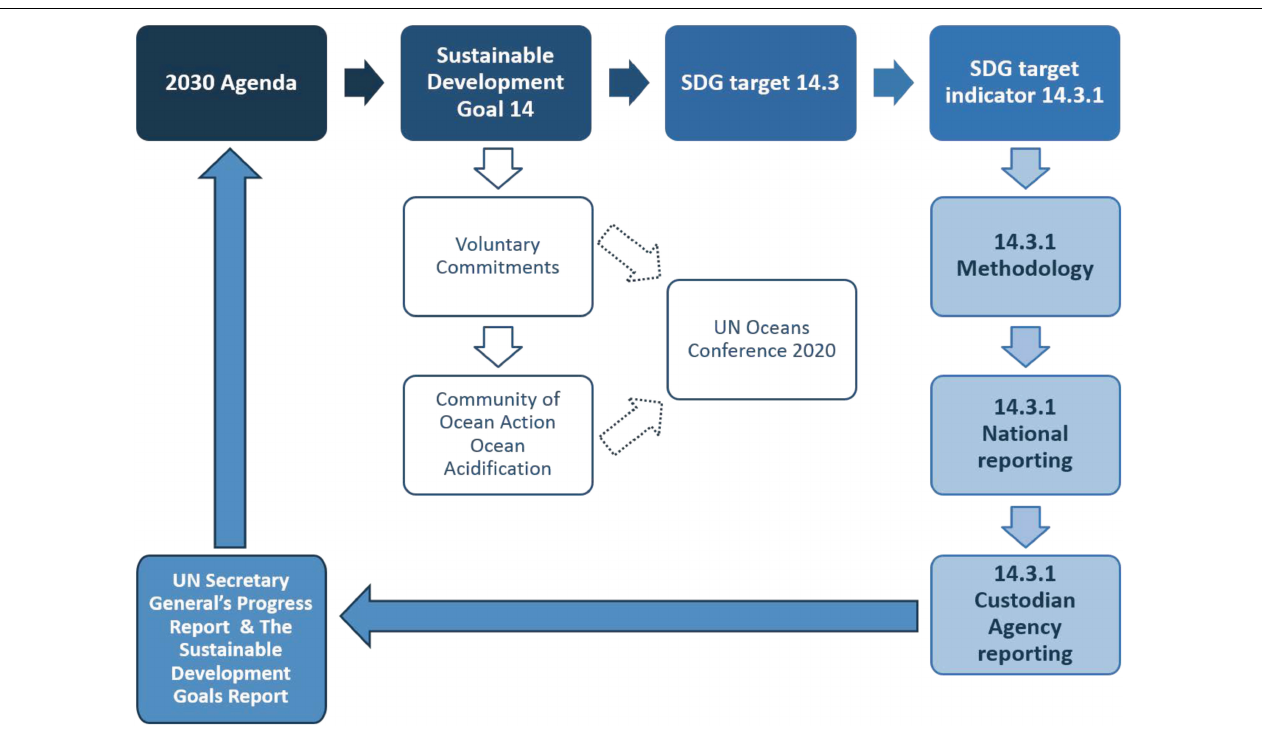
FIGURE 9 | Scheme illustrating the pathways for input to the 2030 Agenda for ocean acidification